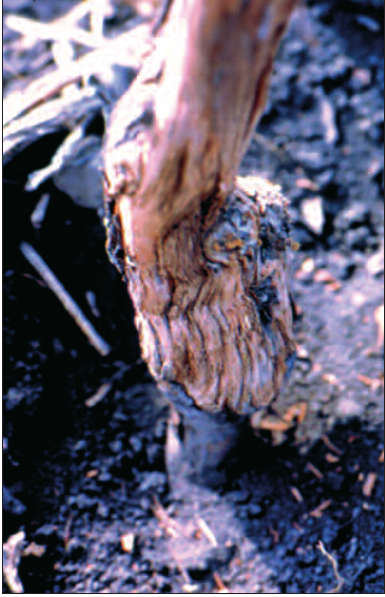
Figure 14. Rugose wood (RW) – corky appearance of the bark above the graft union.